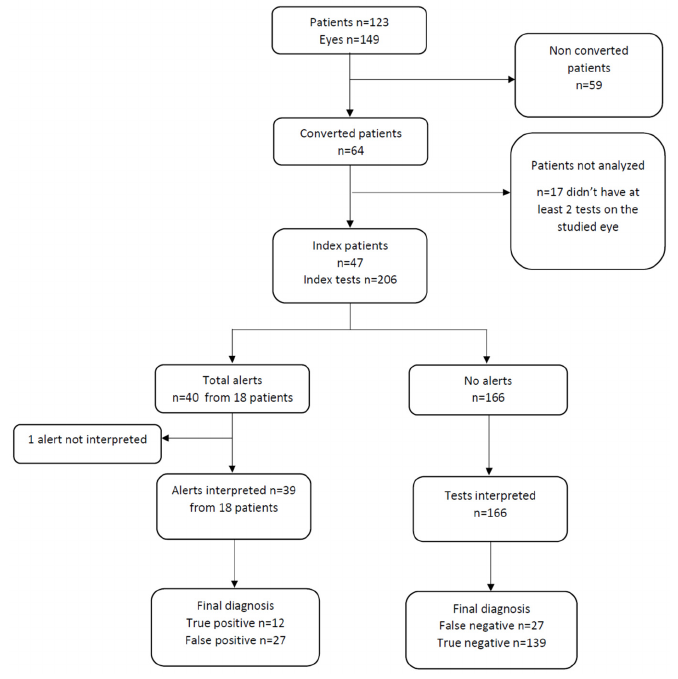
Figure 2. Flow Figure 2. Flow chart. Table 1. Patient characteristics.